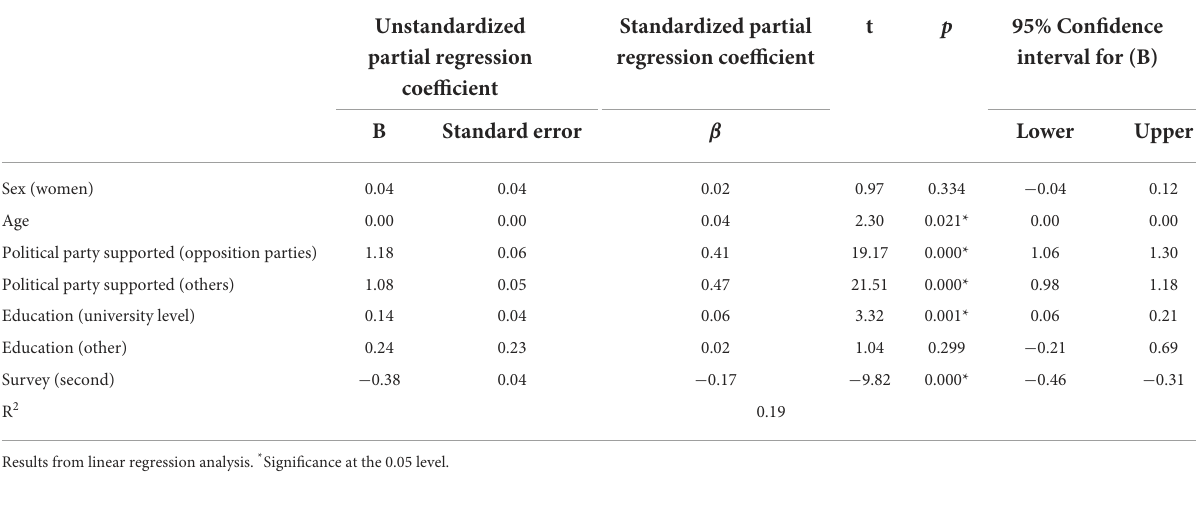
TABLE 1 Statistical analysis of public support for the Japanese government’s approach to COVID-19.